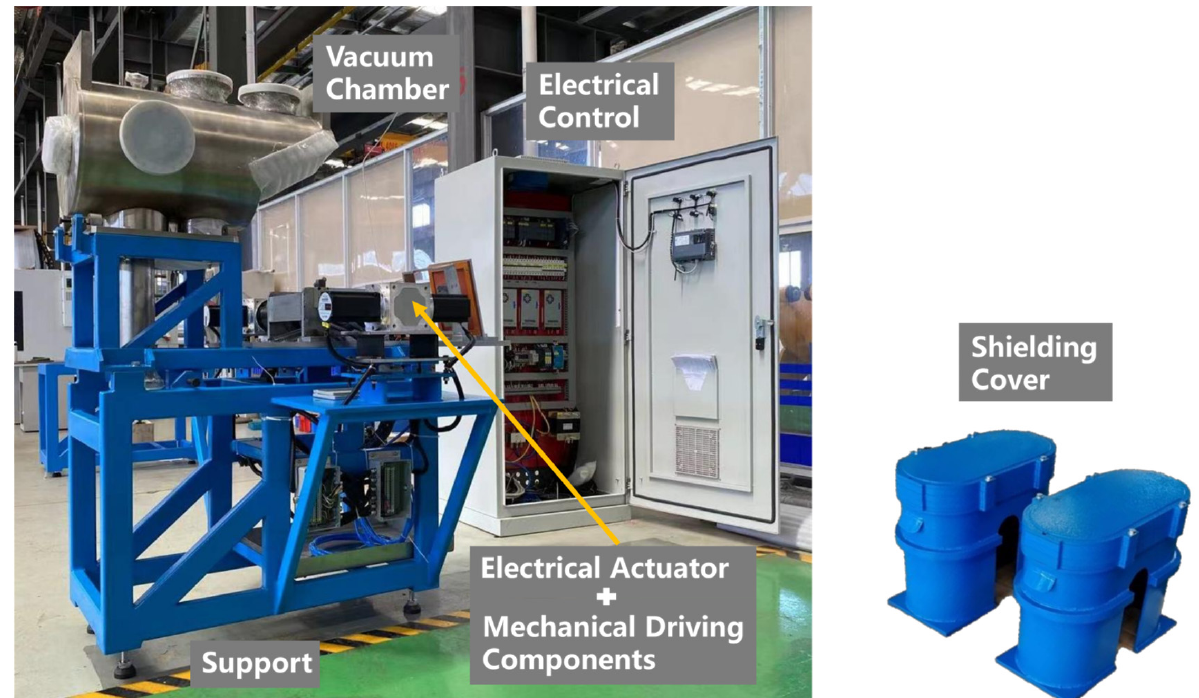
Figure 1. High ‐ power target system developed by Lanzhou University.